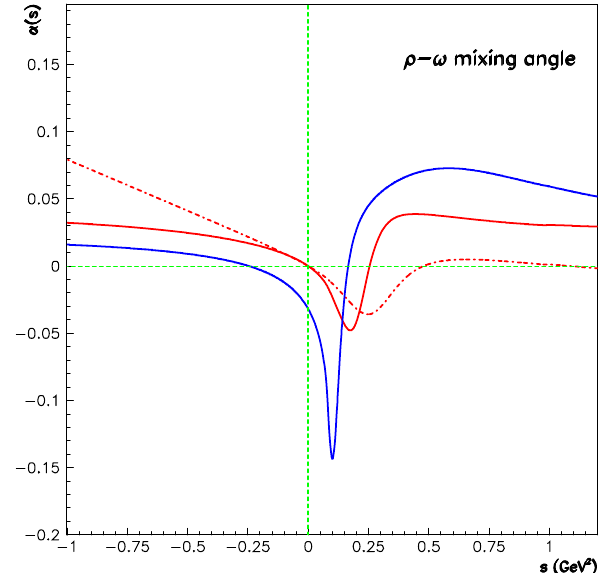
Fig. 1 Real part of the α( s ) mixing “angle”; the full blue curve shows thecaseforthe(former)BHLS,thefullredcurvereferstotheReference Solution of BHLS 2 and the dashed red curve to its Basic Solution. See Sect. 10.3 for more